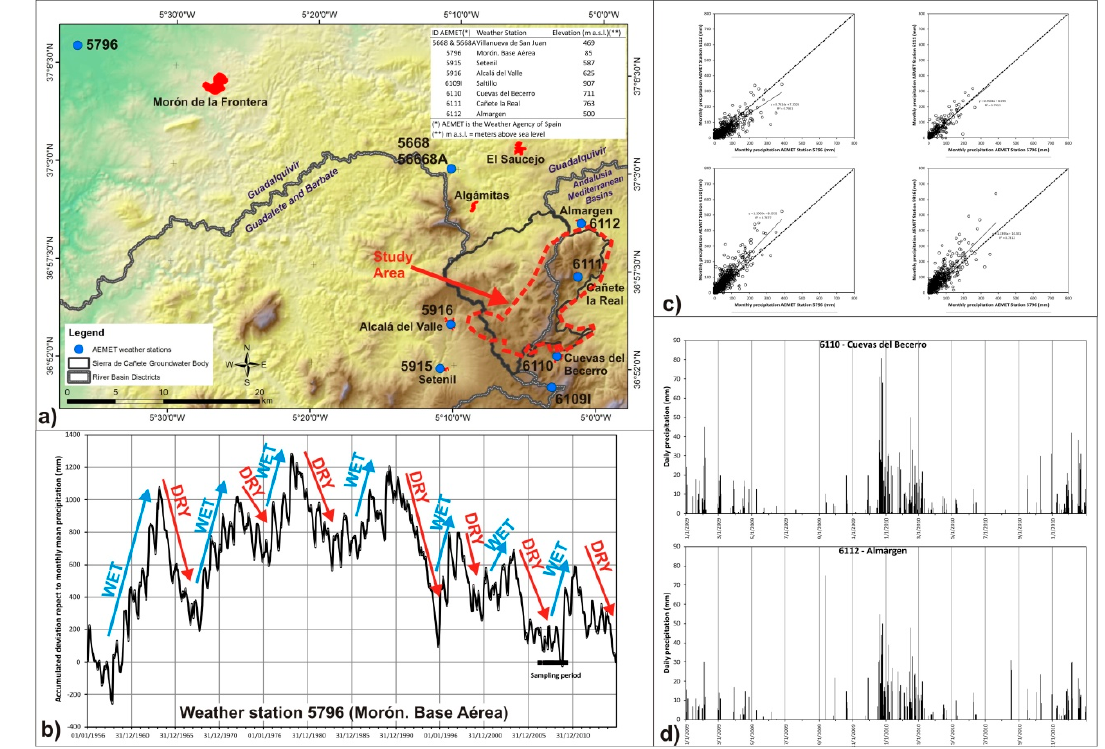
Figure 2. Characteristics of precipitation in the Sierra de Cañete aquifer. ( a ) Situation and elevation of some weather stations used in the analysis of precipitation. ( b ) Accumulated deviation with respect to the monthly mean of precipitation at Station 5796 and the period of hydro-chemical and isotopic sampling. ( c ) Comparison between monthly precipitation at Station 5796 with Stations 6112 (Almargen), 6111 (Cañete la Real), 6110 (Cuevas del Becerro) and 5916 (Alcalá del Valle). ( d ) Daily precipitation during 2009 and 2010 at Stations 6110 (Cuevas del Becerro) and 6112 (Almargen).